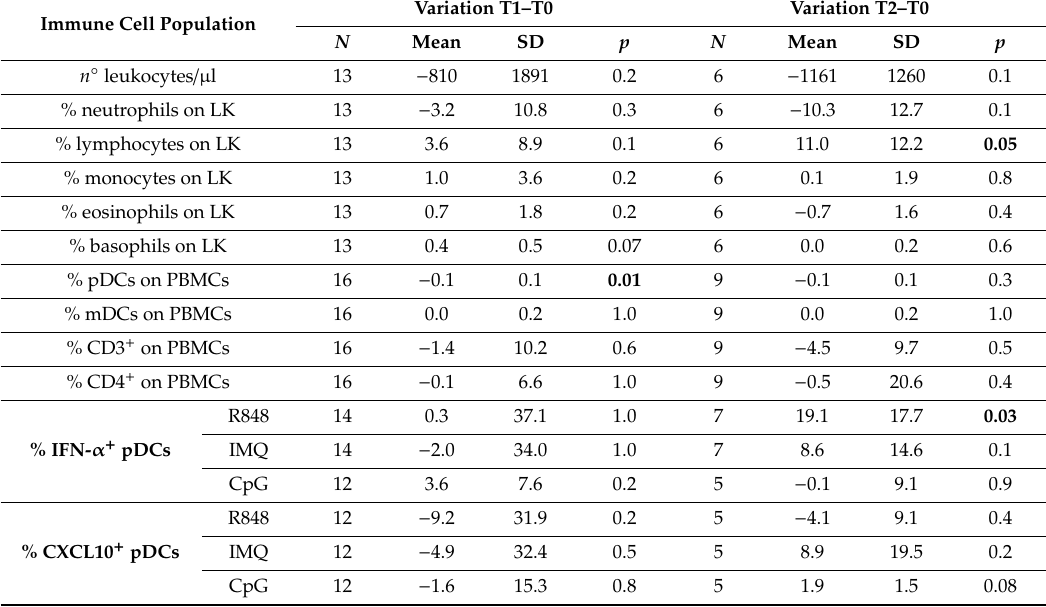
Table 6. Variation of the peripheral blood immune populations at 1 month (T1; N = 12) and 4 months (T2; N = 9) from therapy’s initiation compared to the baseline (T0; N = 16) in the group of BRAF V600 + MM